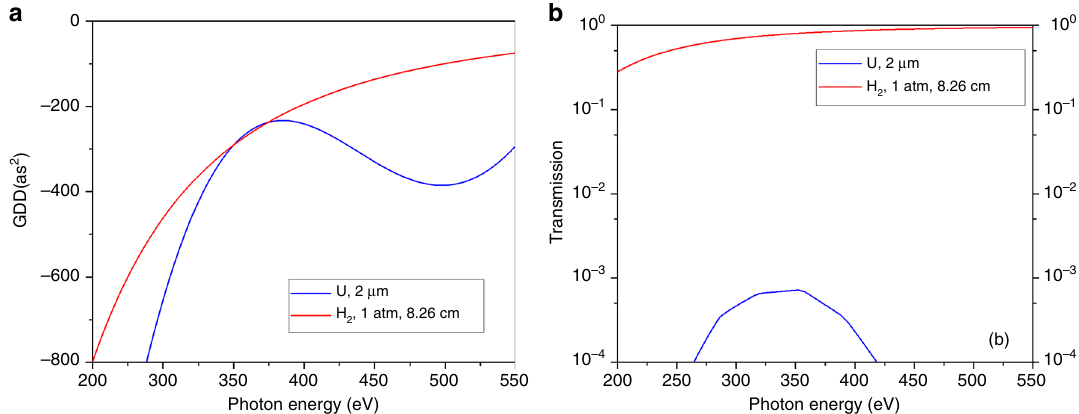
Fig. 1 Atto-chirp compensation in the water window. Comparison of group delay dispersion ( a ) and X-ray transmission ( b ) between a 2- μ m-thick uranium foil and 8.26 cm long, 1 atm H 2 gas from 250 to 550